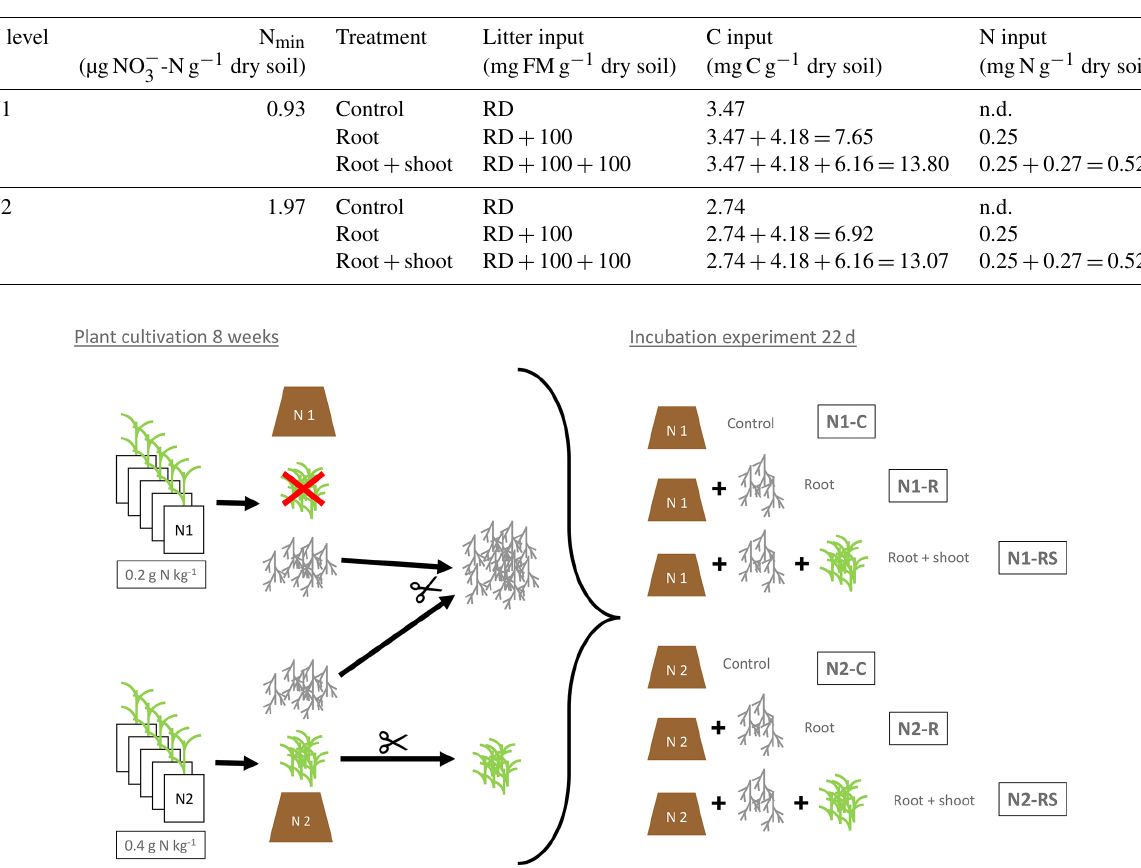
Table 1. Two-factorial setup of the incubation experiment. Soil mineral N (N min ) concentrations were measured directly before onset of the incubation experiment. C input in the control treatment is from rhizodeposition (RD) only, C input in the root treatment is from rhizode- position and roots, and C input in root + shoot is from rhizodeposition, roots, and shoot biomass. N input is from root and shoot biomass, respectively (FM: fresh matter).